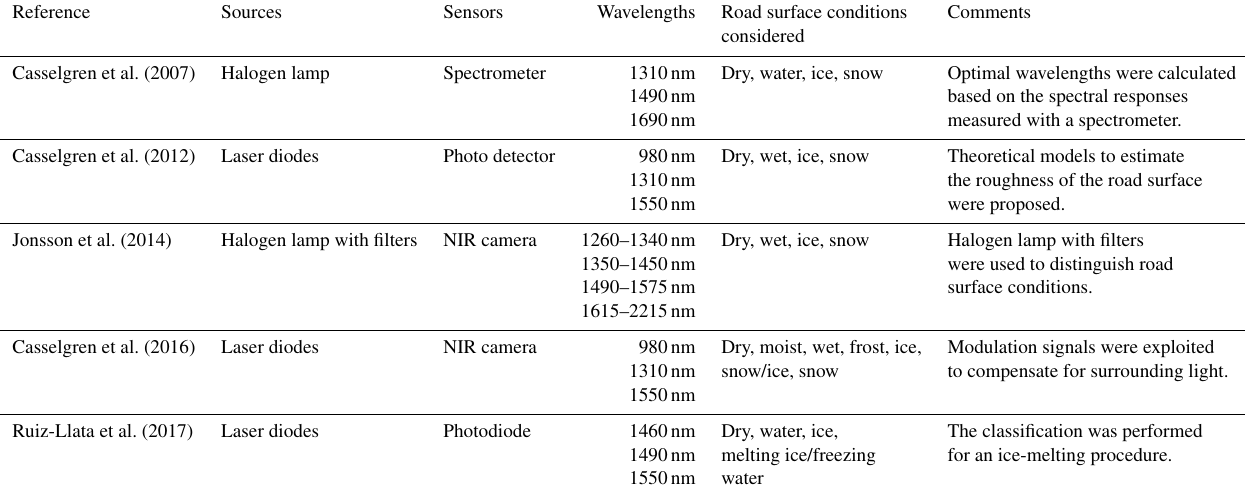
Table 1. Characteristics of the NIR systems described in the